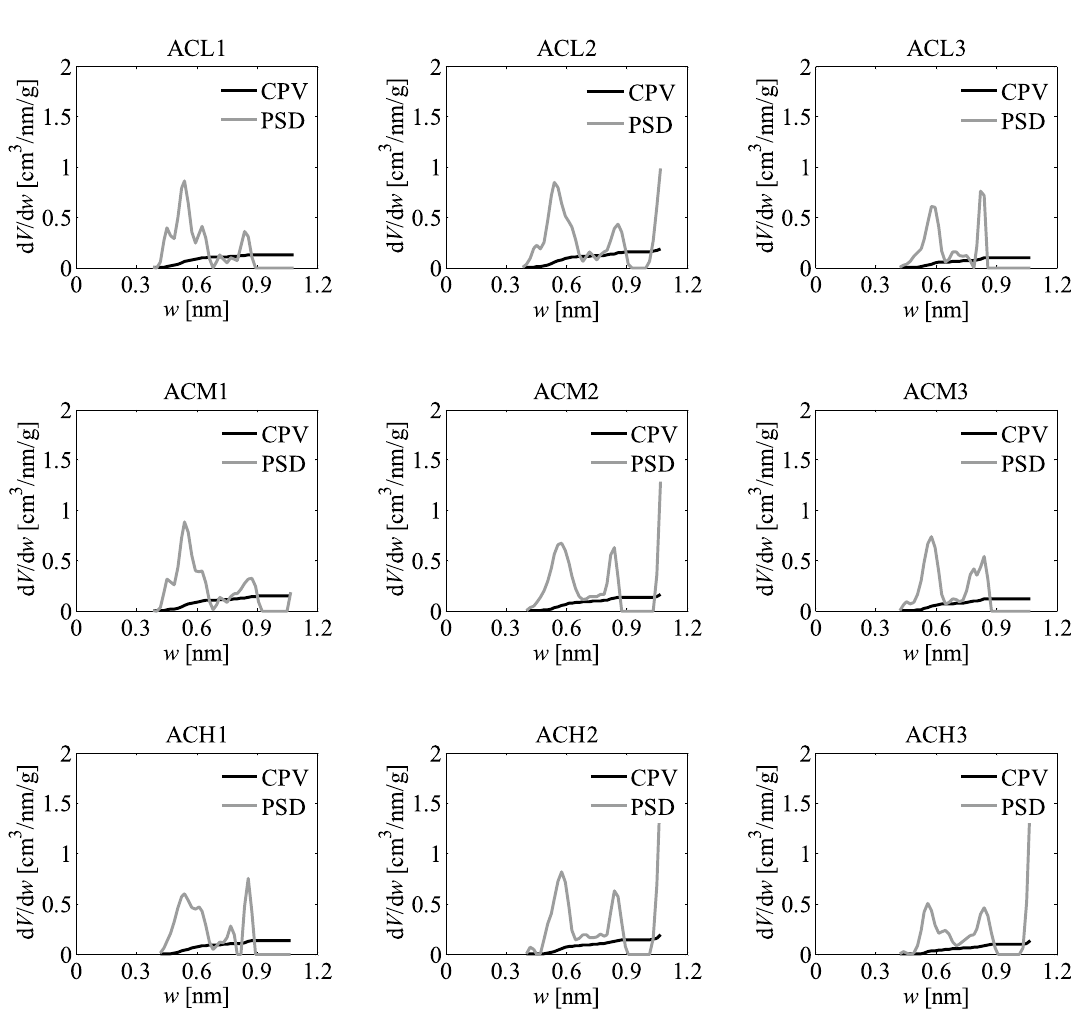
Figure 8. Pore size distributions PSD and cumulative pore volumes CPV obtained for the activated carbons developed with the different temperatures and impregnation ratios, by applying the QSDFT method to the corresponding carbon dioxide adsorption